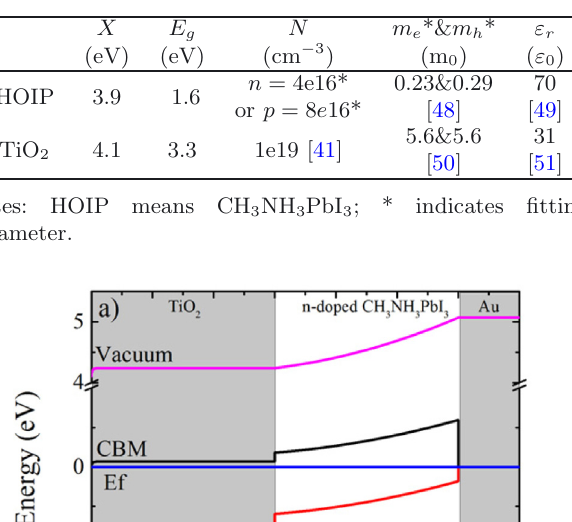
Table 1. Main properties of the materials.